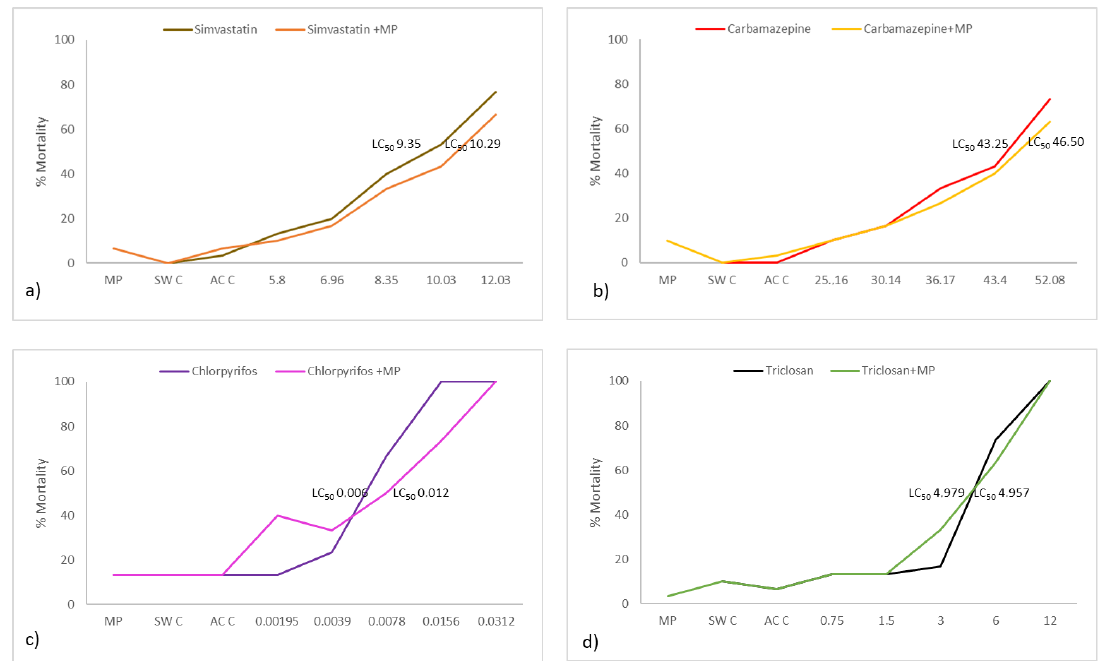
Figure 3. Mortality rate of A. salina after 48 h of exposure to different contaminant concentrations (mg/dm 3 ): ( a ) simvastatin and simvastatin + MP; ( b ) carbamazepine and carbamazepine + MP; ( c ) CPF and CPF + MP; and ( d ) TCS and TCS + MP. Mean values are represented. SW C: Seawater Control; AC C: Acetone